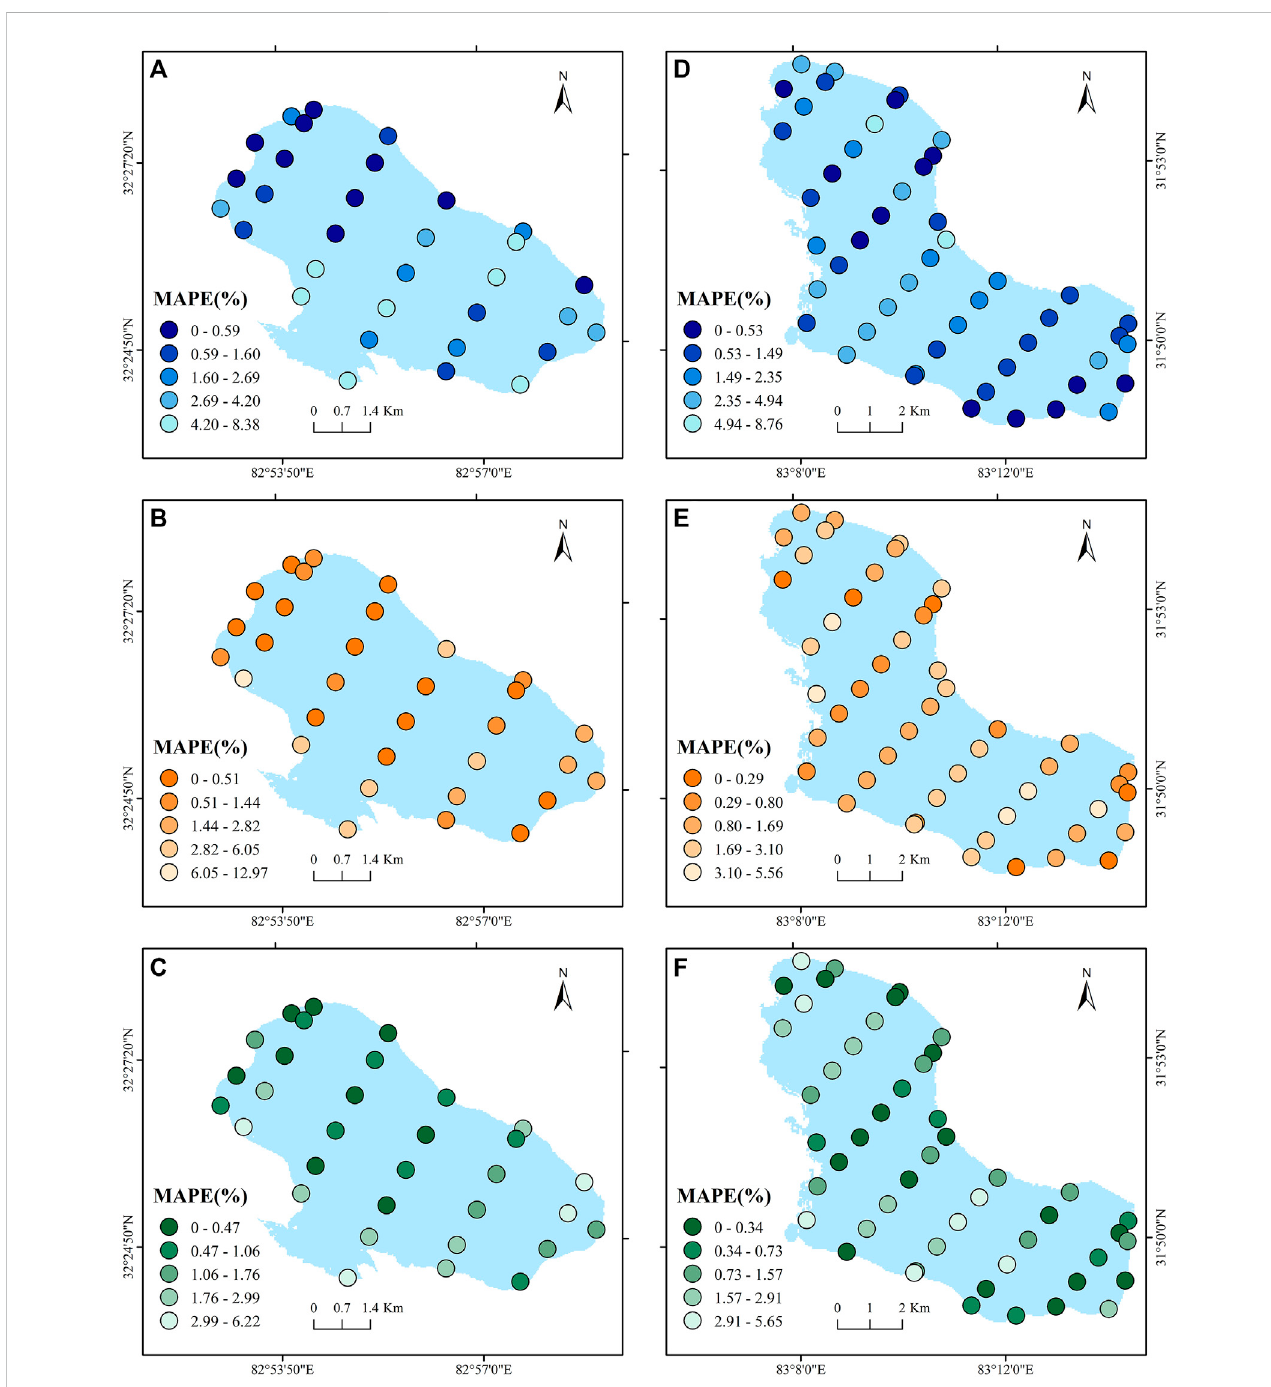
FIGURE 8 Spatial distribution map of MAPE at sampling points in Bieruoze Co and Guopu Co by using GA-RF model. (A) , (B) and (C) are the MAPE of Li, B, and TDS, respectively, estimated by Bieruoze Co. (D) , (E) and (F) are the MAPE of Li, B, and TDS, respectively, estimated by Guopu Co.